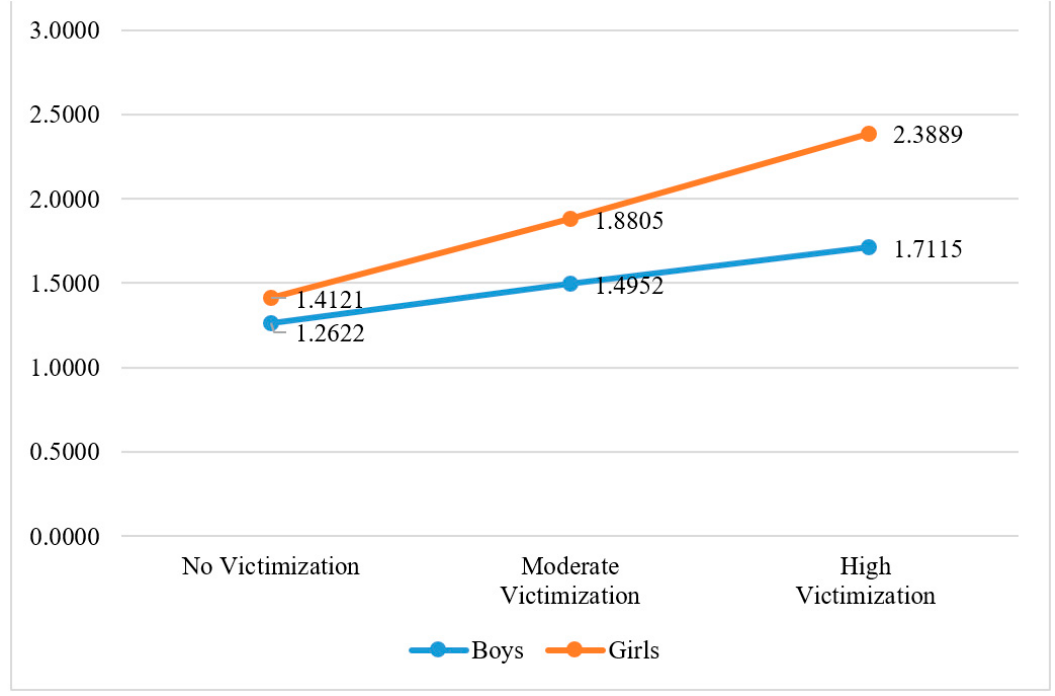
Figure 1. Marginal means of suicidal ideation and gender.